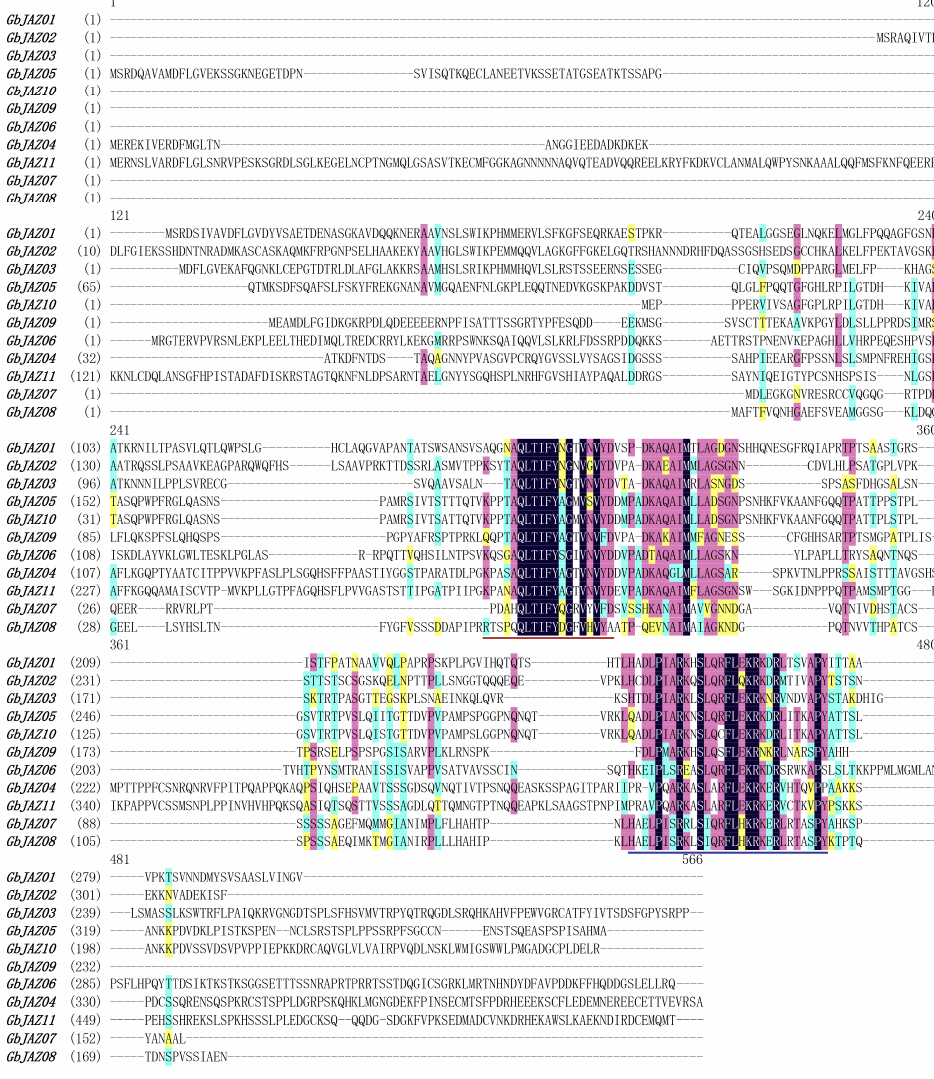
Figure 3. Multiple sequence alignment of GbJAZs. The red underlined area is the TIFY domain and the blue underlined area is the Jas domain.